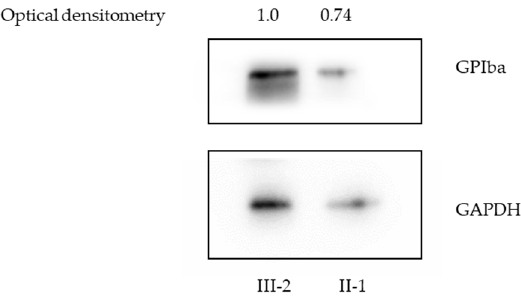
Figure 6. Immunoblot analysis of platelets proteins of patient II-1 and healthy individual III-2 showed decreased expression of GPIb α 1ba in patient II-1 (0.74) compared with healthy individual III-2 (1.0). Antibody GPIba, Rabbit (1:3000), Sigma-Aldrich, antibody GAPDH, Rabbit (1:3000), Cell Signaling.